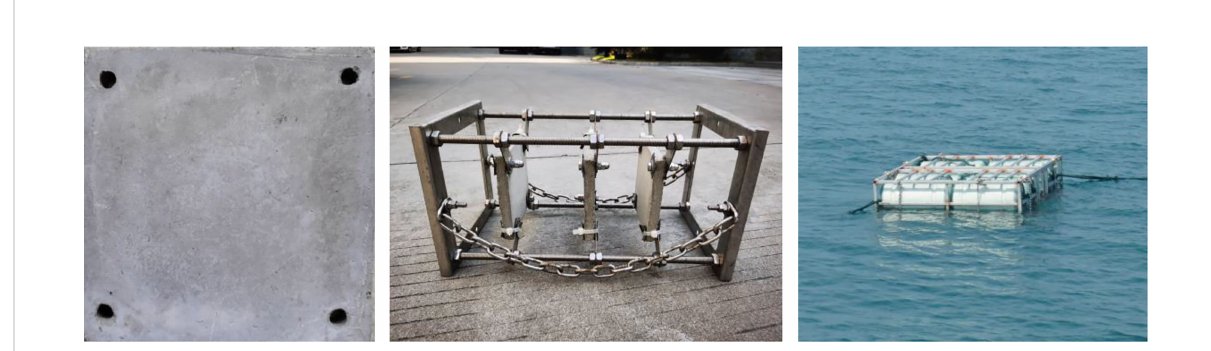
FIGURE 2 Test panel, hanging plate fi xing device and experimental fl oating raft.